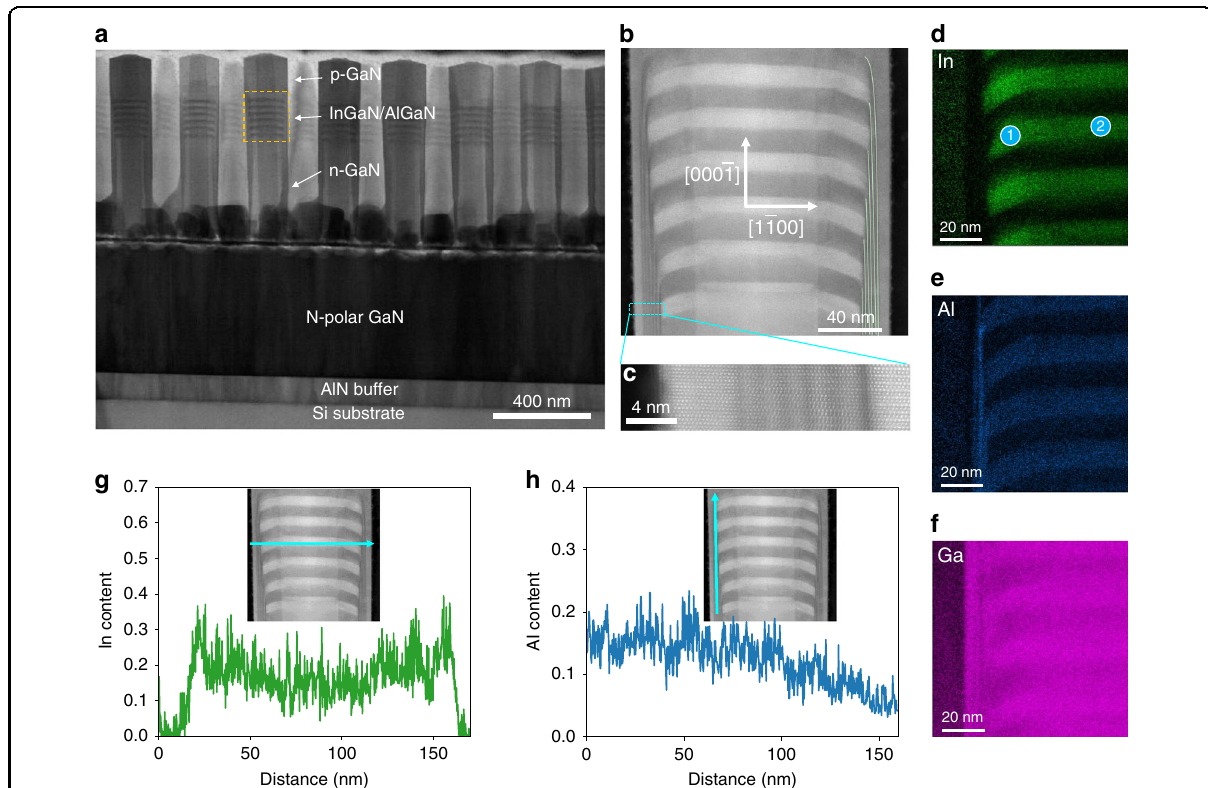
Fig. 2 Structural characterizations of InGaN MQWs-in-nanowire heterostructure grown on Si substrate. a Low-magni fi cation bright- fi eld STEM image of InGaN/AlGaN nanowire heterostructure grown on GaN/AlN/Si substrate. b Magni fi ed HAADF-STEM image of the orange-boxed region in a . The green curves indicate the AlGaN shells formed around the active region. c High-magni fi cation HAADF image of the cyan-boxed region in b , wherein the six pairs of GaN/AlGaN superlattice on the sidewall are observed. d – f EDS element maps of the active region of InGaN/AlGaN MQWs. Indium composition point scans were performed at point 1 and 2 as indicated in d . g Indium element pro fi le along the cyan arrow as shown in the inset. h Al element pro fi le along the cyan arrow as shown in the